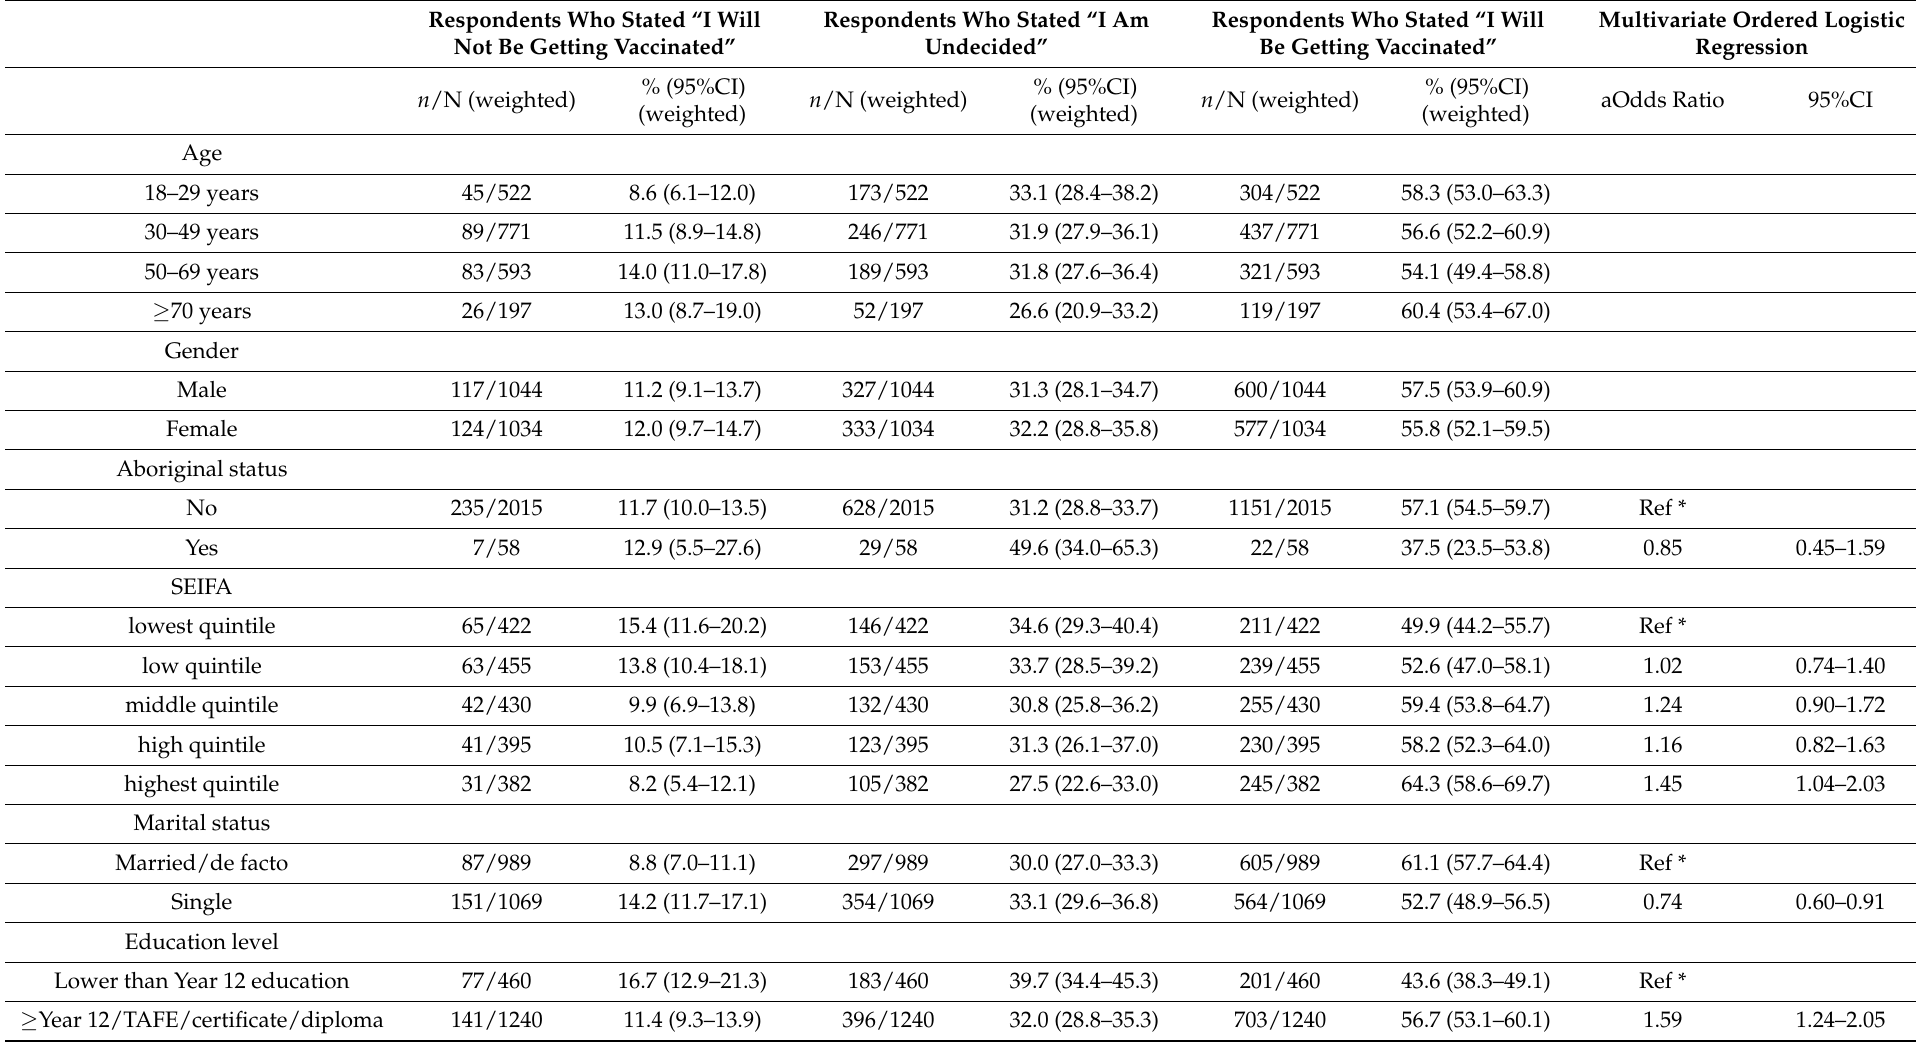
Table 4. Weighted and adjusted odds ratios of likelihood of taking the COVID vaccine